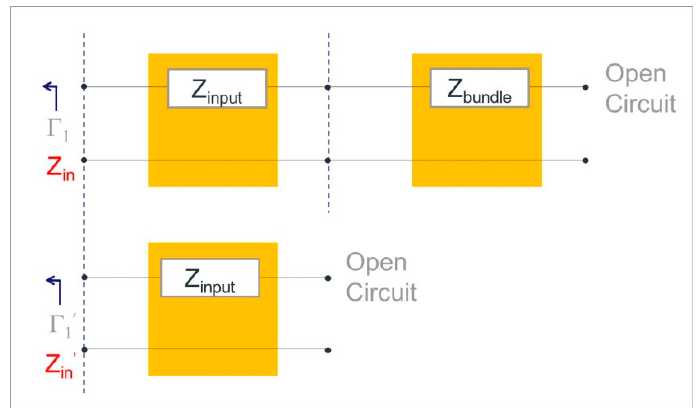
Figure 2. Schematic representation of the complex impedance extraction of VA (vertically aligned) MWCNT bundles from a two-device set.